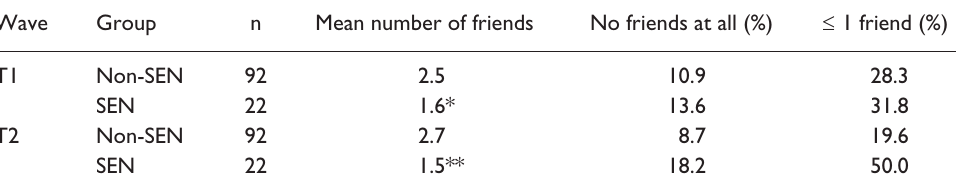
Table 1. Number of friendships (reciprocal choices).